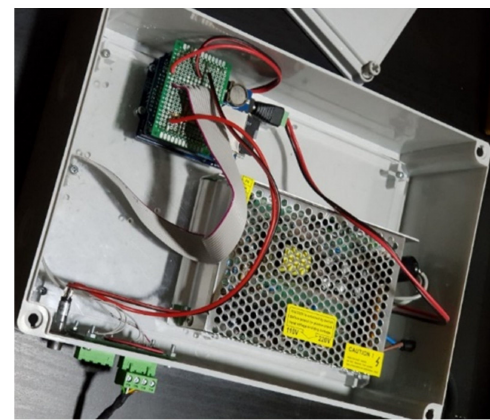
Figure 2. Microcontroller.